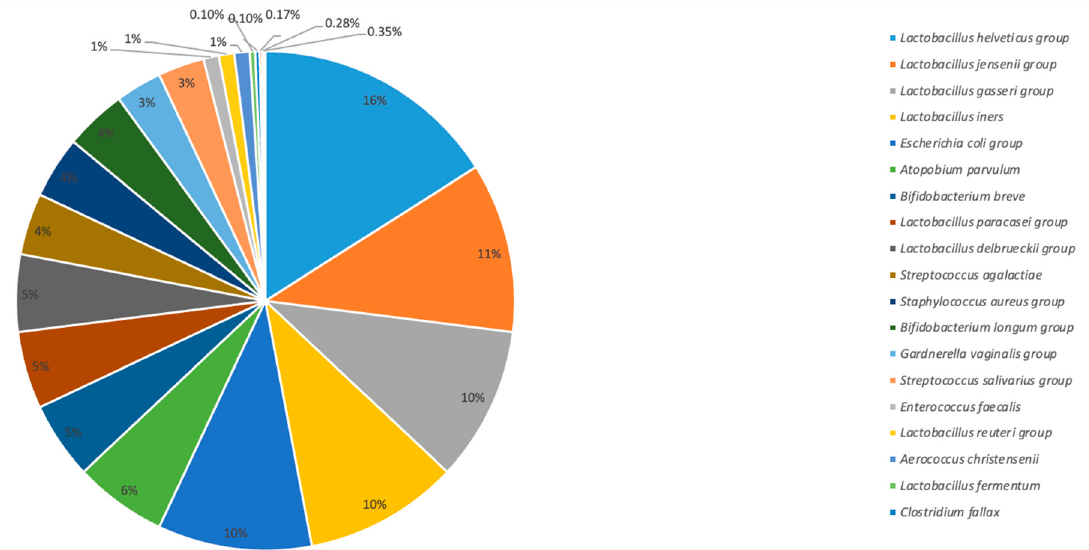
Figure 2. Percentage of individual bacteria strains colonizing the endometrium and the uterine cervix of patients qualified for the IVF procedure.